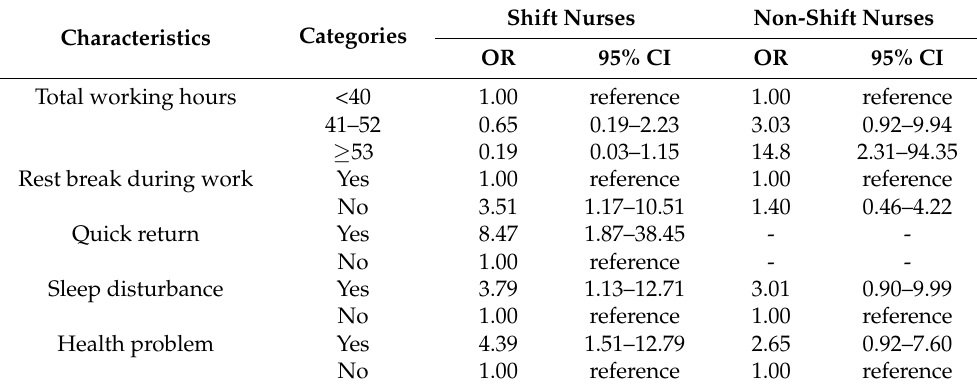
Table 3. The odds ratios of working hour characteristics and health status on sickness presenteeism ( n =